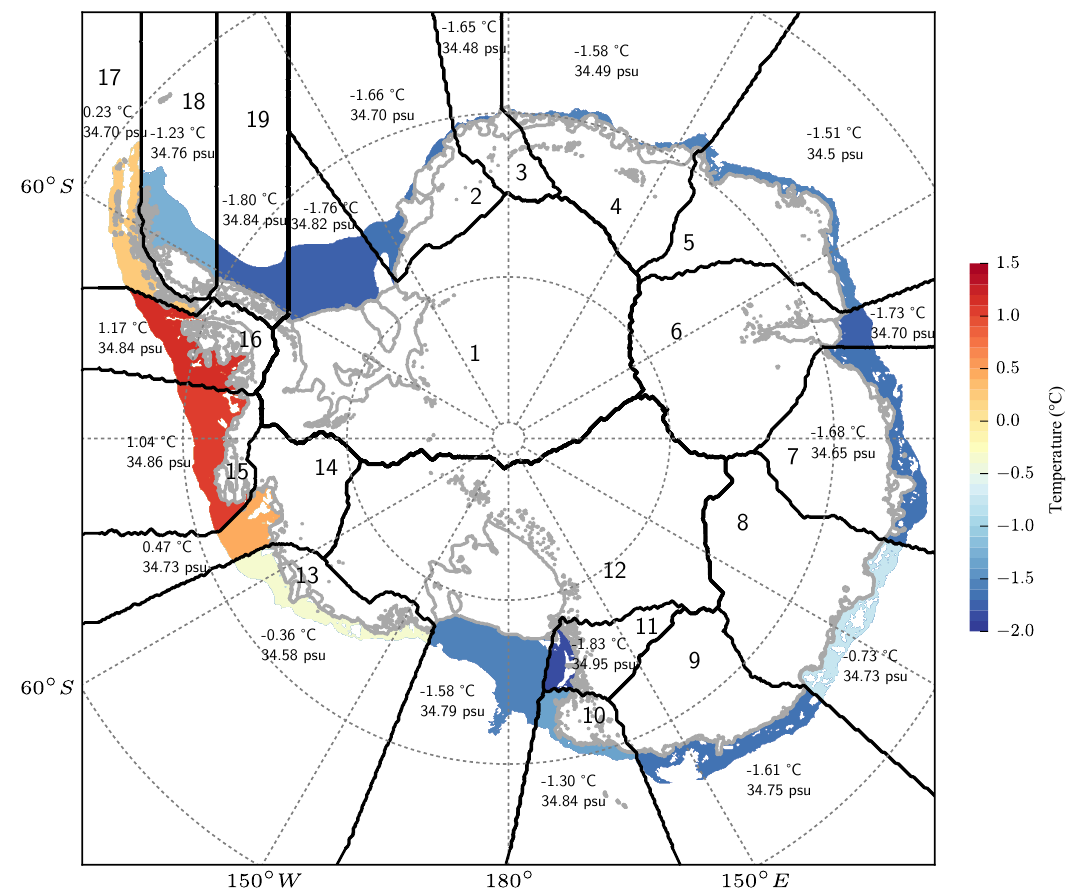
Figure 2. PICO input for Antarctic basins. The ice sheet, ice shelves and the surrounding Southern Ocean are split into 19 basins that are based on Zwally et al. (2012) and indicated by black contour lines and labels. For each ice shelf, the governing equations are solved separately with the respective oceanic boundary conditions. For ice shelves that cross basin boundaries, the input is averaged, weighted with the fractional area of the shelf within the corresponding basin. Numbers show the temperature and salinity input in each basin, obtained by averaging observed properties of the ocean water in front of the ice-shelf cavities at depth of the continental shelf (Schmidtko et al., 2014), indicated by the color shading. Grey lines show Antarctic grounding lines and ice-shelf fronts (Fretwell et al.,